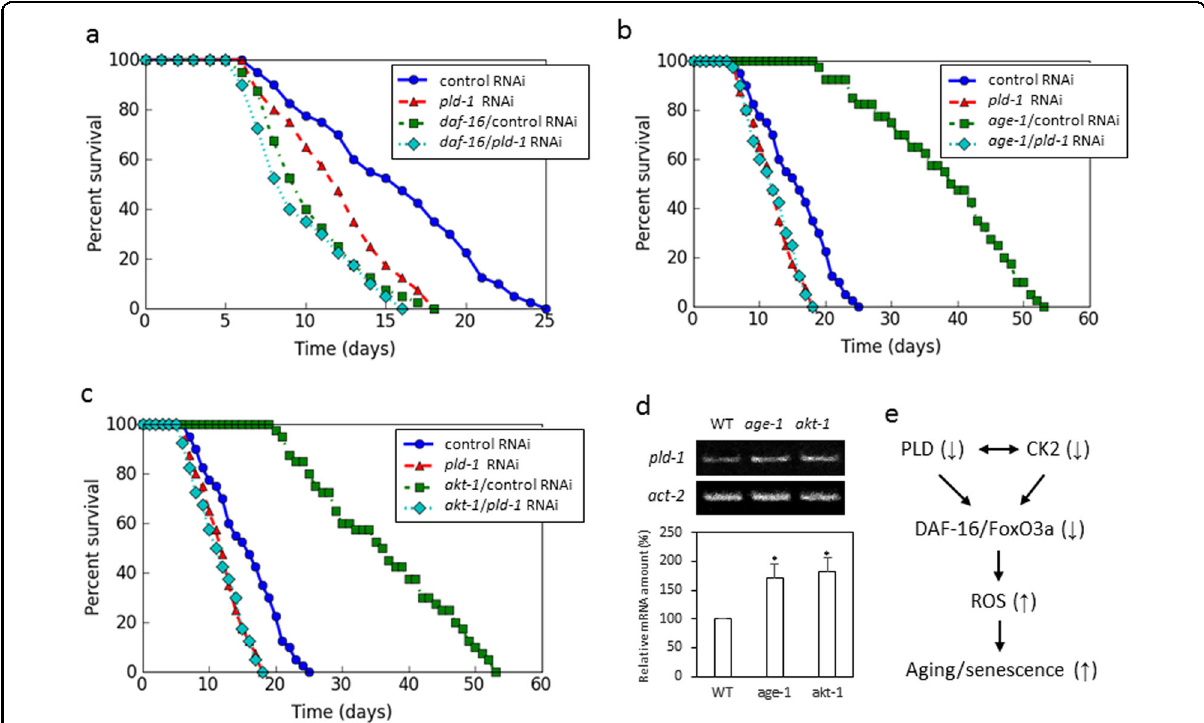
Fig. 6 Effect of pld-1 RNAi on the lifespan of daf-16 , age-1 , and akt-1 single-mutant nematodes. Daf-16(mu86) ( a ), age-1(hx546) ( b ), and akt-1 (mg144) ( c ) single-mutant nematodes were fed on control RNAi or pld-1 RNAi plates under standard conditions ( n = 40 per condition). Viability was scored as movement away from pick touch at the indicated days. Representative data from three independent RNAi experiments are shown. d Effect of age-1(hx546) or akt-1(mg144) mutation on pld-1 expression. Lysates from nematodes at days 12 of adulthood were utilized in RT-PCR using speci fi c pld-1 primers. PCR products were resolved on a 1.5% agarose gel (upper panel). Representative data from three independent experiments are shown. act-2 mRNA served as the loading control. The graph shows the relative mRNA level of pld-1 (lower panel). Data are shown as the means±SEM. * P < 0.05. e Possible model illustrating the role of DAF-16/FoxO3a in aging and senescence induced by PLD downregulation in C. elegans and human